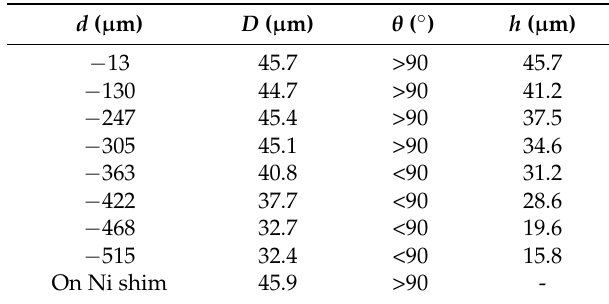
Figure 2. Morphology of the microstructures. Scanning electron micrographs of UA16 micropillars fabricated with different distances, d , between template and wet coating: ( a ) − 13 µm, ( b ) − 130 µm, ( c ) − 247 µm, ( d ) − 305 µm, ( e ) − 363 µm, ( f ) − 422 µm, ( g ) − 468 µm, and ( h ) − 515 µm. Scale bars are 40 µm. ( i ) Illustration of micropillar shape distortions due to deformation of the flexible mold during imprinting and curing (left) and upon demolding (right). These distortions led to variation of the pillar diameter at the connection to the backing layer, D, the angle between pillar sidewall and backing layer, θ , and the backing layer thickness, h (see Table 2).